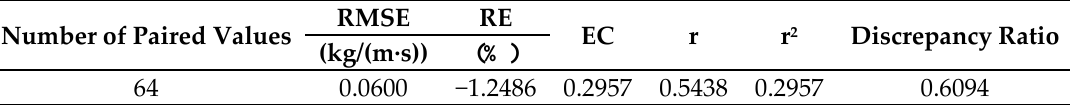
Table 3. Statistical criteria values of Nest os River (5 ‐ point moving average measured values, optimization).